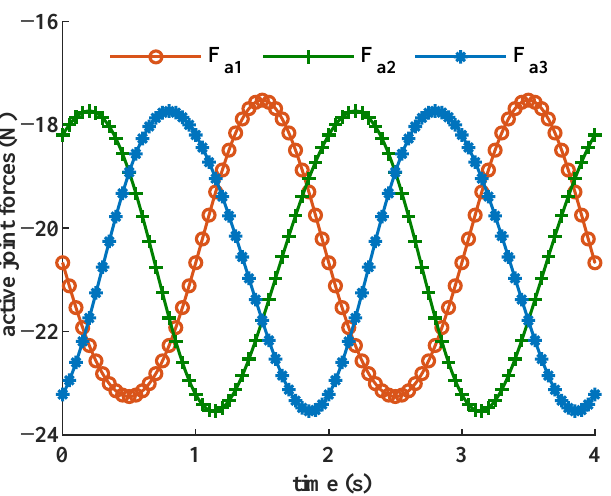
Figure 9. Required active joint forces computed from the proposed dynamic model.